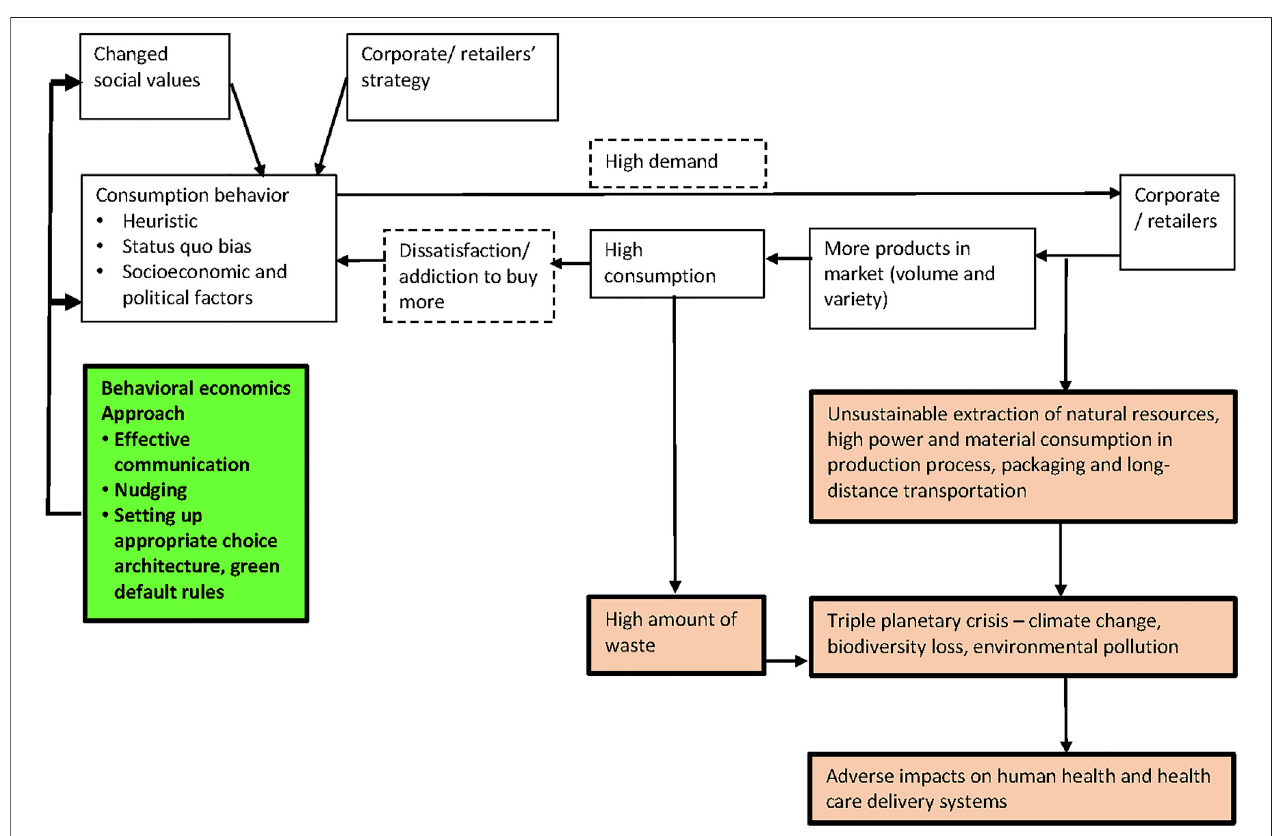
FIGURE 1 | Flow diagram of high consumerism and planetary health crisis and potential roles for behavioral